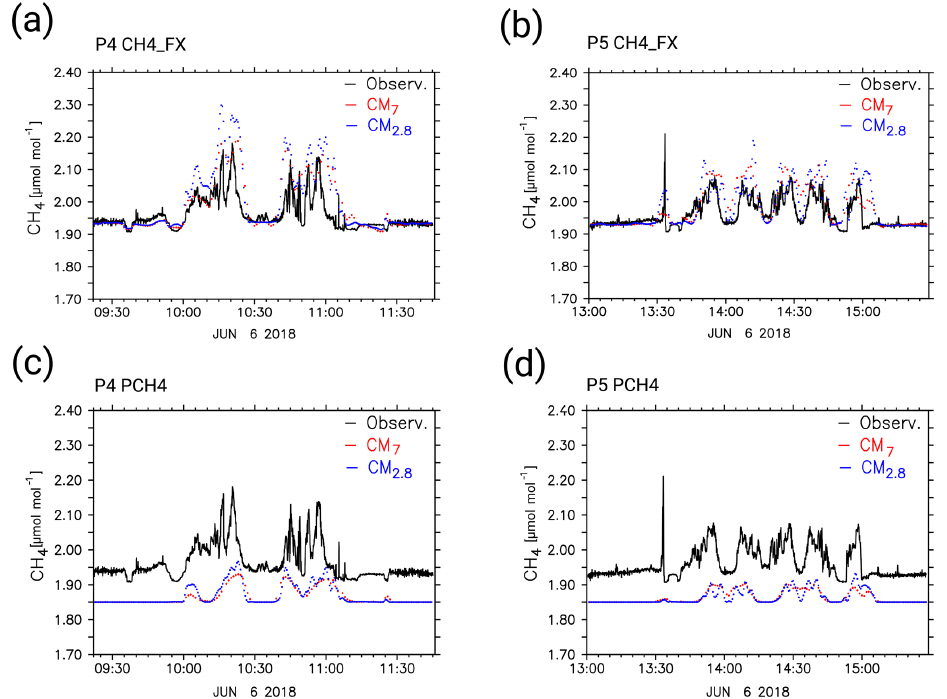
Figure 10. D-FDLR in situ sampled CH 4 mixing ratios (black lines) of P4 (a, c) and P5 (b, d) , as well as the S4D submodel output at flight altitude for CM7 (red dots) and CM2.8 (blue dots). Panels (a) and (b) show the comparison with the CH4_FX tracer, whereas (c) and (d) show the comparison with the PCH4 tracer. All mixing ratios are in micromoles per mole (µmolmol − 1 ). CH4_FX is bias-corrected with 0.108µmolmol − 1 , and an offset of 1.85µmolmol − 1 is added to PCH4 for a better visualization. The time axis displays the time of the specific flight in